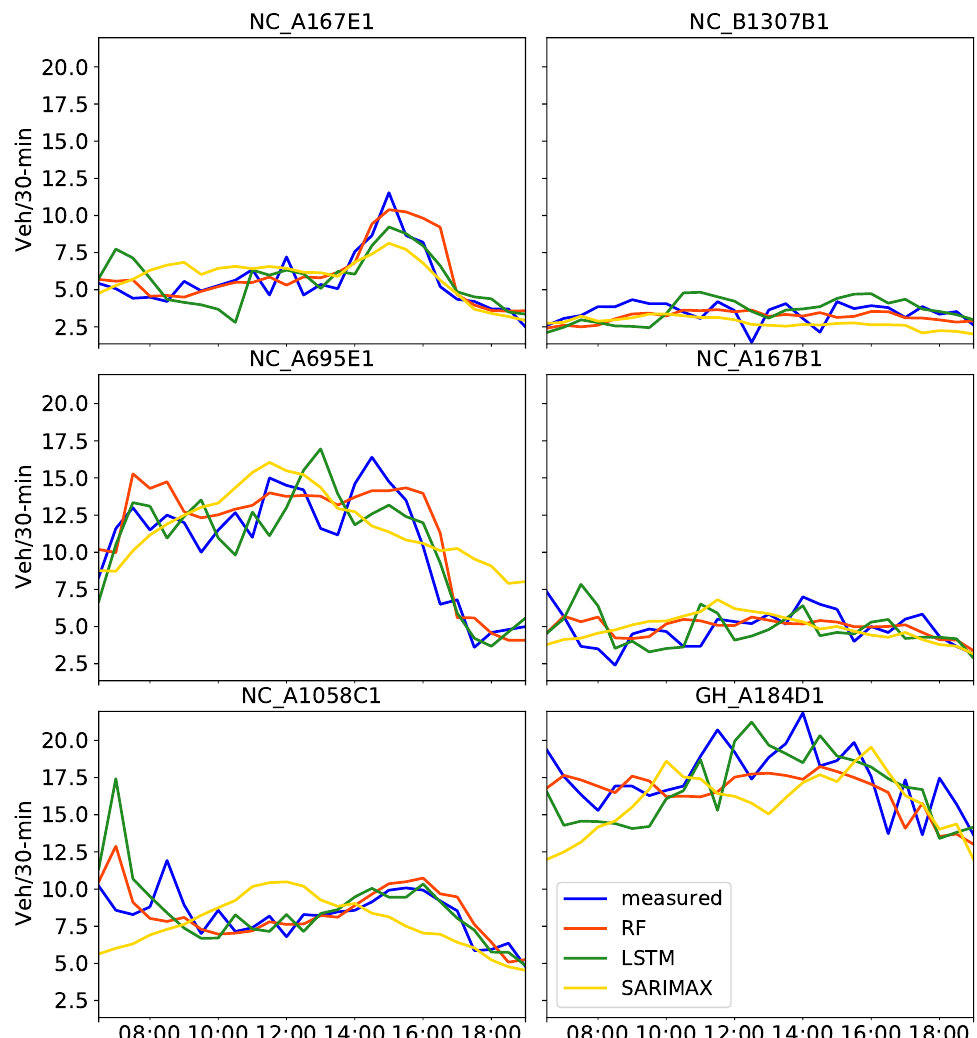
Figure 7. Predictions on 2 August 2019 obtained with three tuned models, RF, LSTM and SARIMAX, using the past one month of training data including four exogenous attributes. Measured traffic volume constitutes the “ground